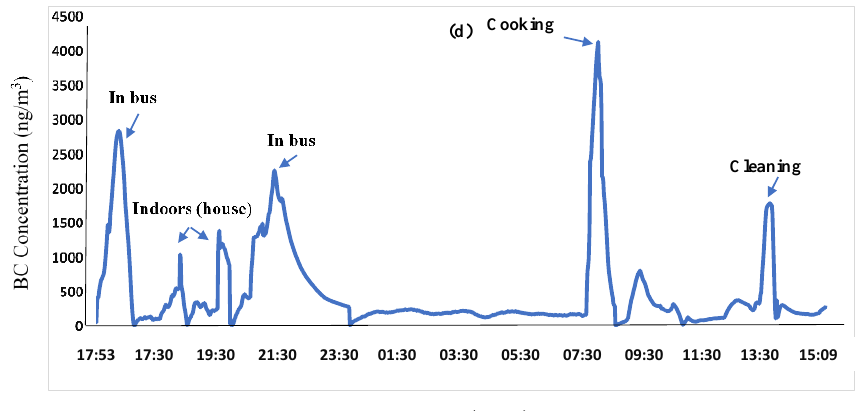
Figure 5. Exposure concentration variations for 24 h in Albany, NY (Campaign 6): ( a ) PM 10 , ( b ) PM 2.5 , ( c ) PM 1 , and ( d ) BC.